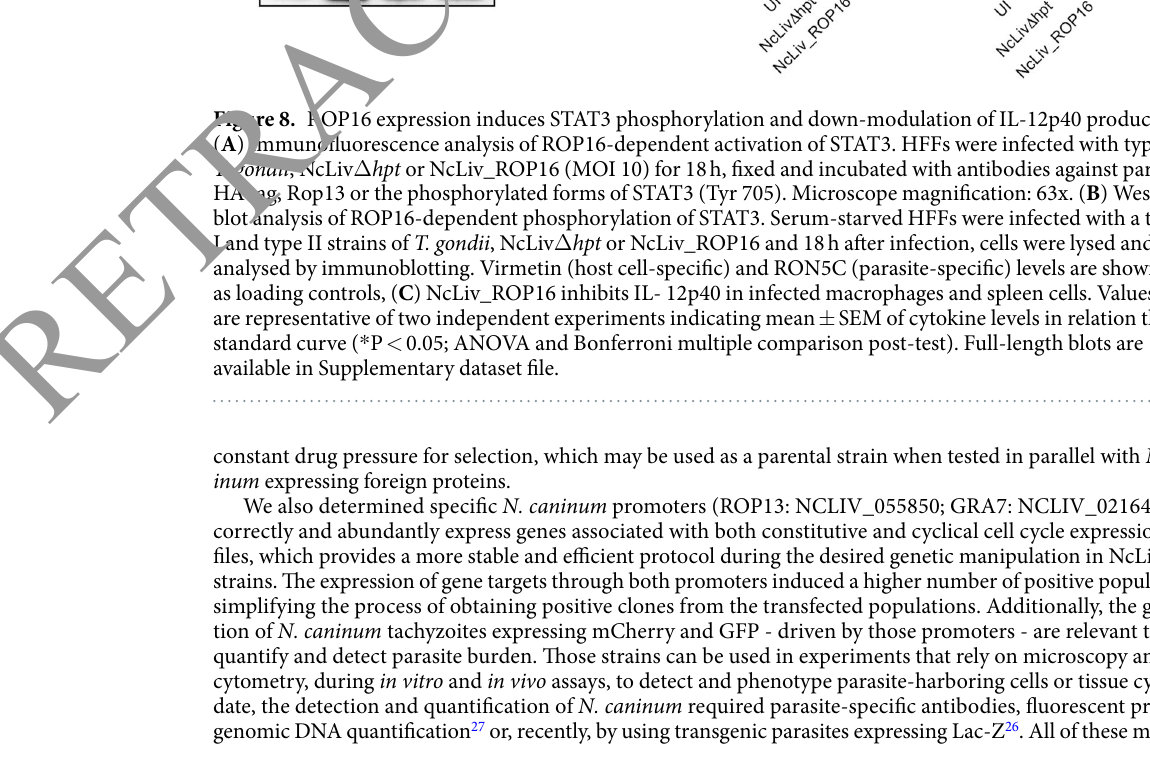
8 Scientific RepoRts | 7: 3768 | DOI:10.1038/s41598-017-03978-1